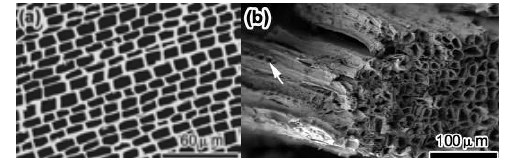
Fig. 4 SEM images of cross section of (a) carbonized Pine and (b) Pine-templated